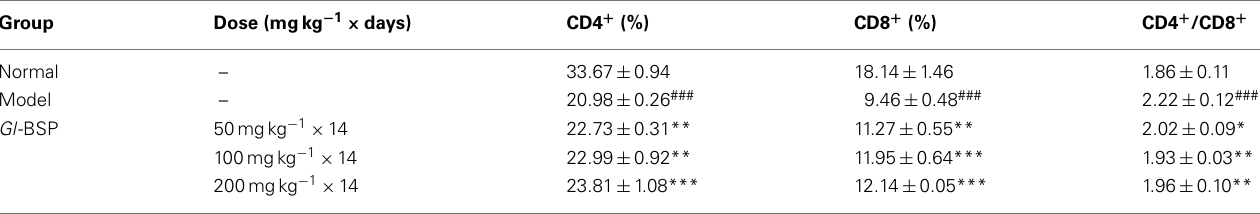
Table 6 | Effect of Gl- BSP onT lymphocyte subpopulation in S180-bearing mice ( n = 3, ¯ x ± s).